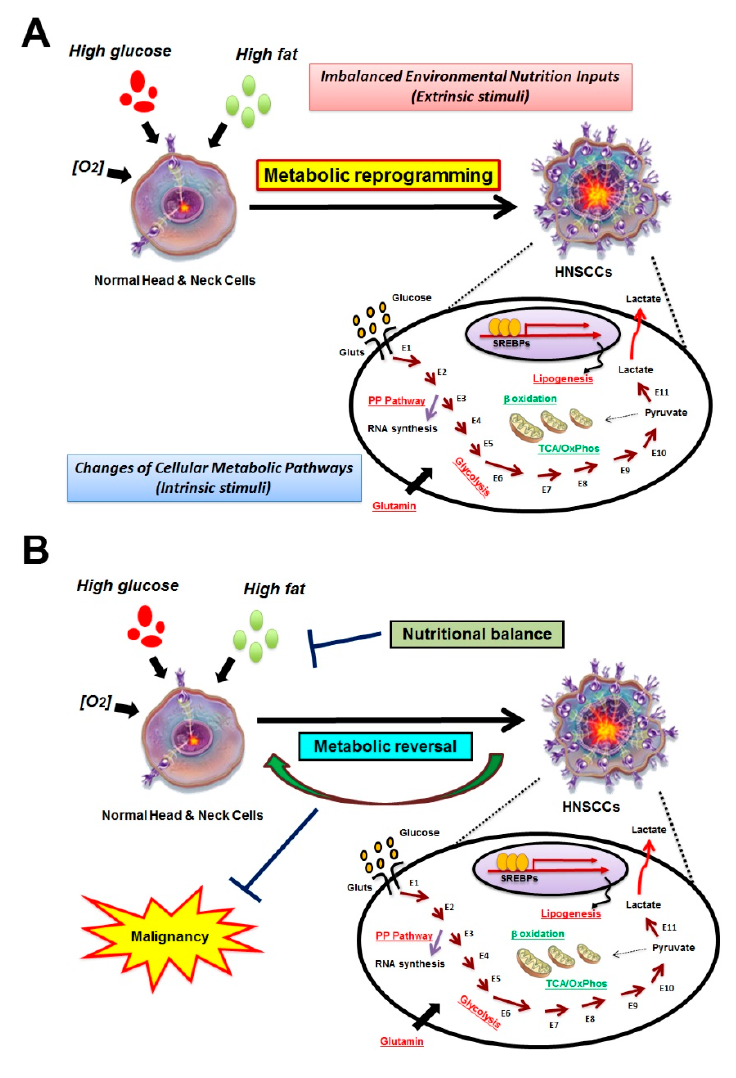
Figure 1. Metabolic reprogramming in HNSCCs. ( A ) Diagraphic illustration of the metabolic shift during the oncogenic transformation in HNSCC cells. The pathways presented in red indicate the pathways upregulated in HNSCC cells compared to normal cells, while the metabolic pathways shown in green are pathways less active in tumors; ( B ) the nutritional balance (e.g., maintenance of normoglycemia in DM patients) and reverse for intrinsic metabolic cues by inhibitors could be a potential method to suppress cancerous identity in HNSCCs. E1-E11: Enzymes in glycolytic pathway.